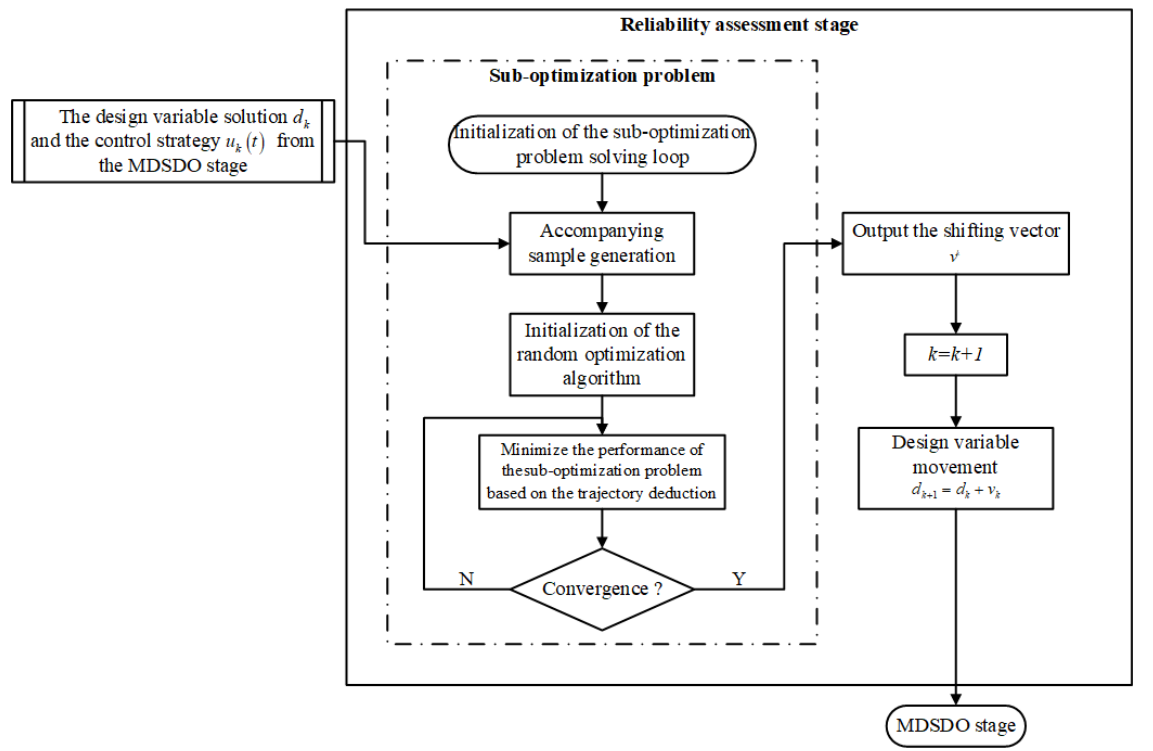
Figure 5. The flow chart of the proposed reliability assessment loop.